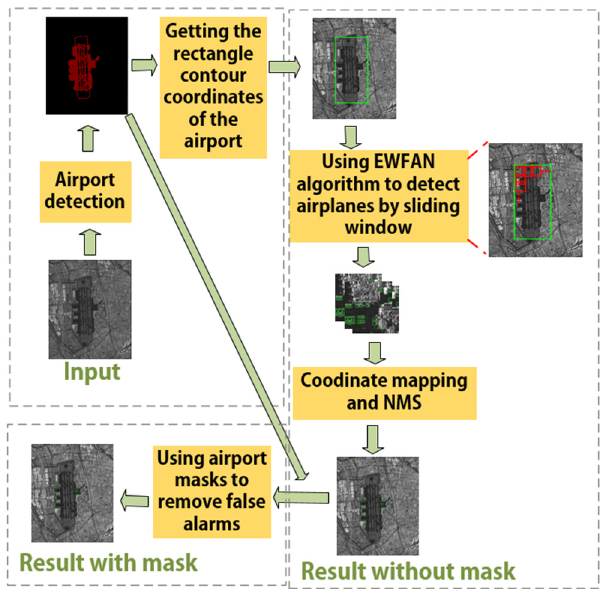
Figure 1. The efficient framework for aircraft detection.